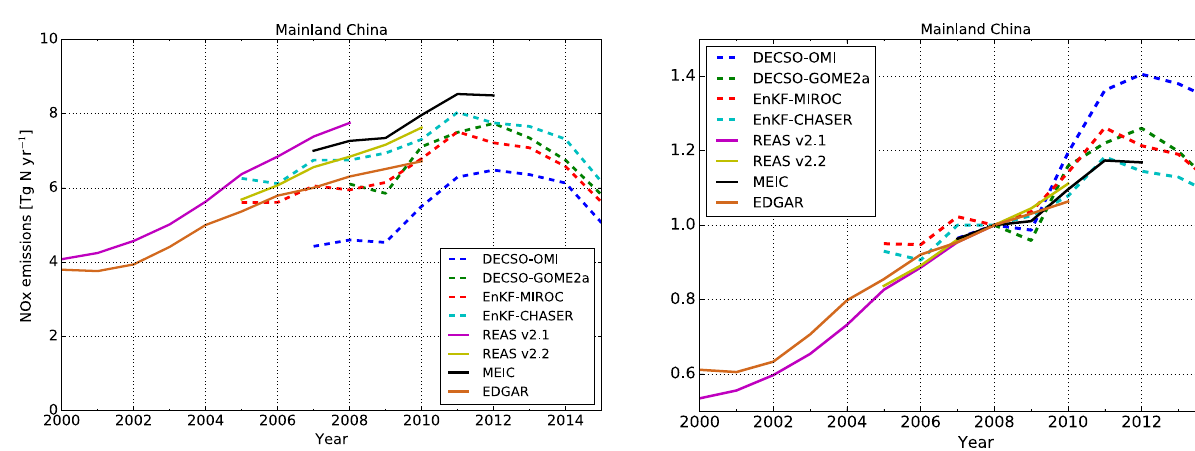
Figure 3. Normalized annual NO x emissions from eight emission inventories over mainland China in the selected domain (see Fig. 1). The time series are normalized to their value in 2008.